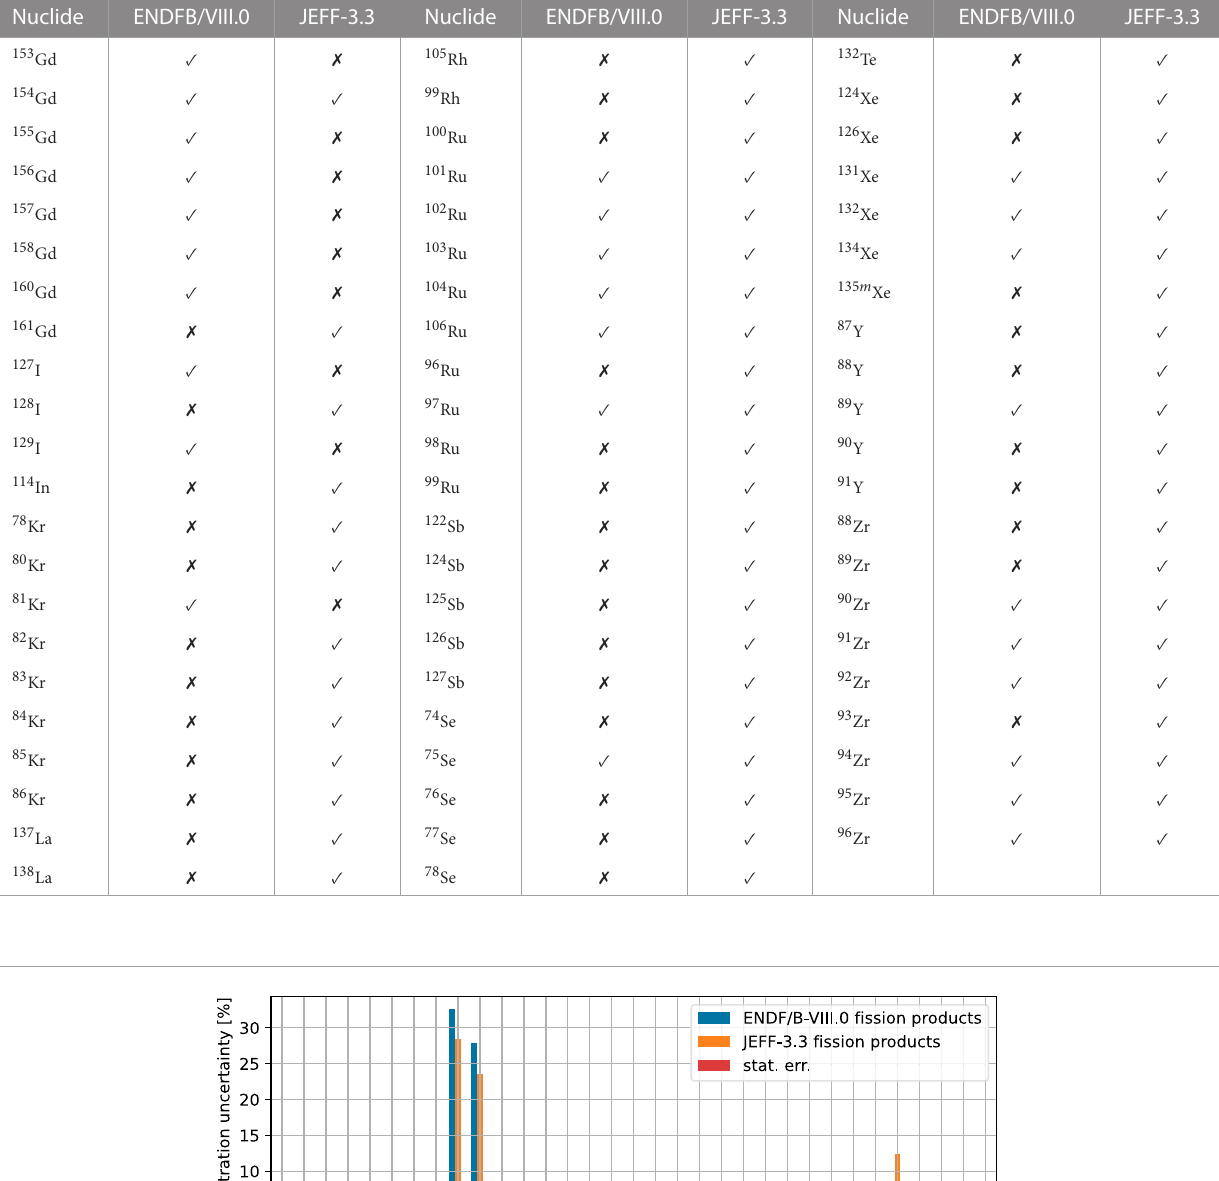
TABLE3 ( Continued )Fissionproductswhosecross-sectioncovariancematriceswereconsideredintheuncertaintypropagationstudy. Nuclide